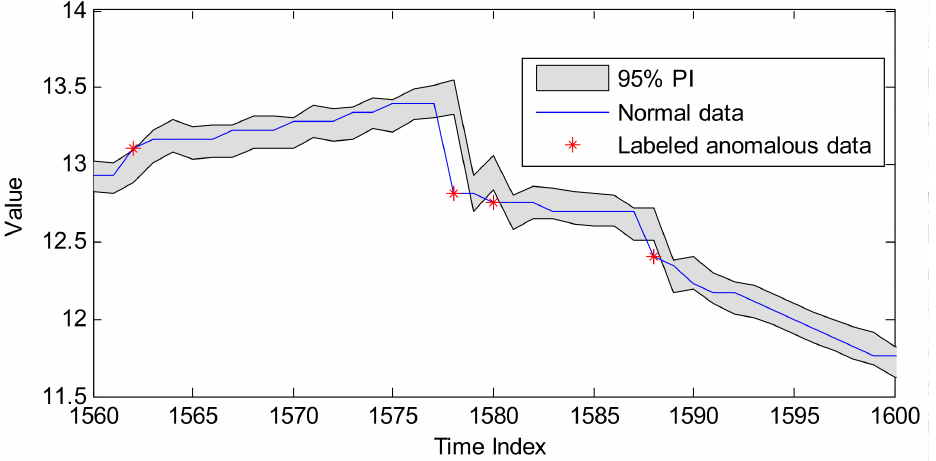
Figure 2. An example of anomaly detection with